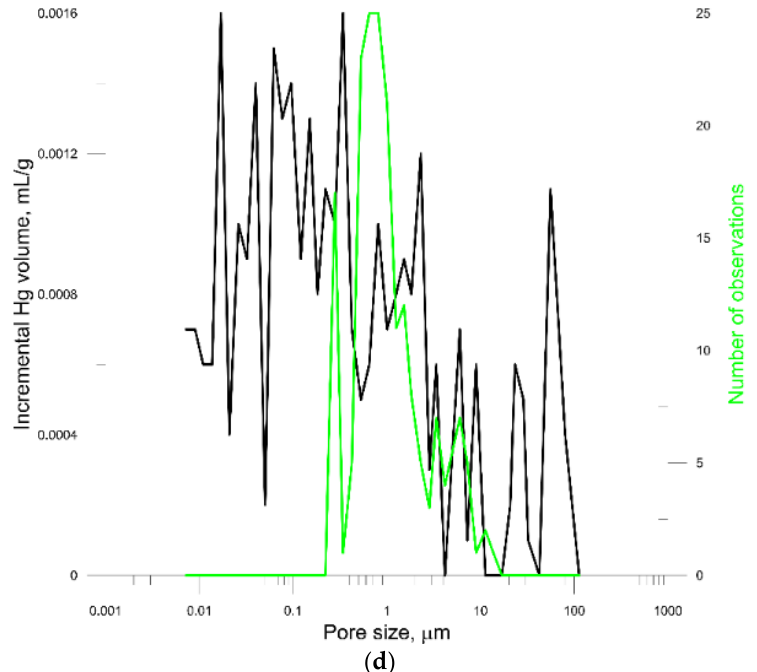
Figure 8. ( a ) Pore size distribution from MICP (black) and CT (green) for exemplary sandstone sample 16. ( b ) Pore size distribution from MICP (black) and CT (green) for exemplary mudstone sample 31. ( c ) Pore size distribution from MICP (black) and CT (green) for exemplary limestone sample 46. ( d ) Pore size distribution from MICP (black) and CT (green) for exemplary dolostone sample 50.